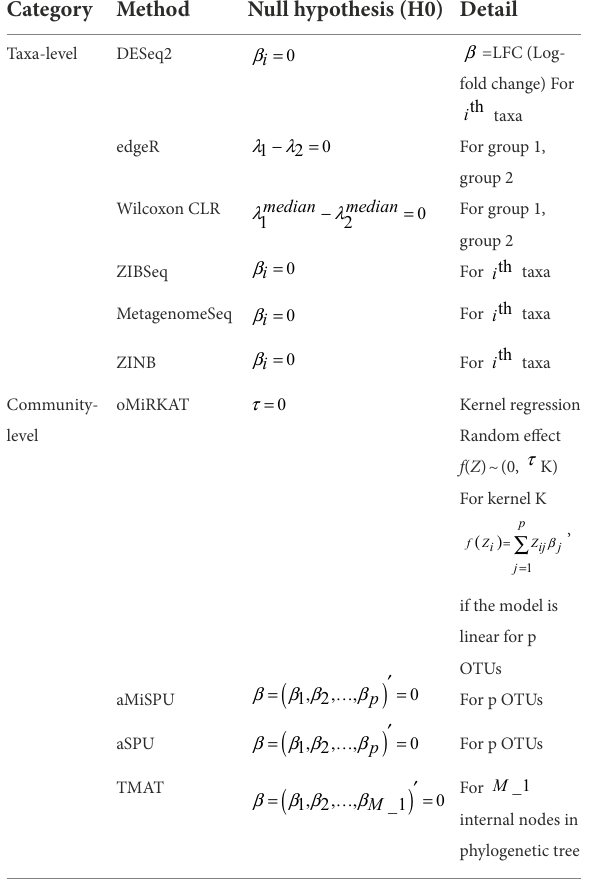
TABLE 1 Null hypotheses of statistical